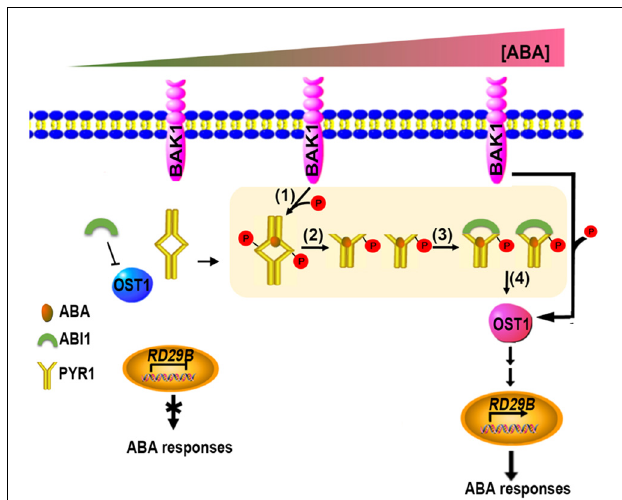
FIGURE 8 | Updated model showing coordination of the initial stage of ABA signaling. When ABA levels were absent or very low, OST1 was mainly suppressed by ABI1. When ABA levels increase, increased interaction of BAK1 with PYR1 occurs, resulting in more phosphorylated PYR1 (1). These events facilitate ABA binding to PYR1 simultaneously, and parallel by dissociating the PYR1 dimer (2) and ABI1 binding to ABA-bound PYR1 (3). This binding results in free OST1 being released from inhibition by ABI1 (4), leading to further activation of various downstream ABA signaling outputs in this